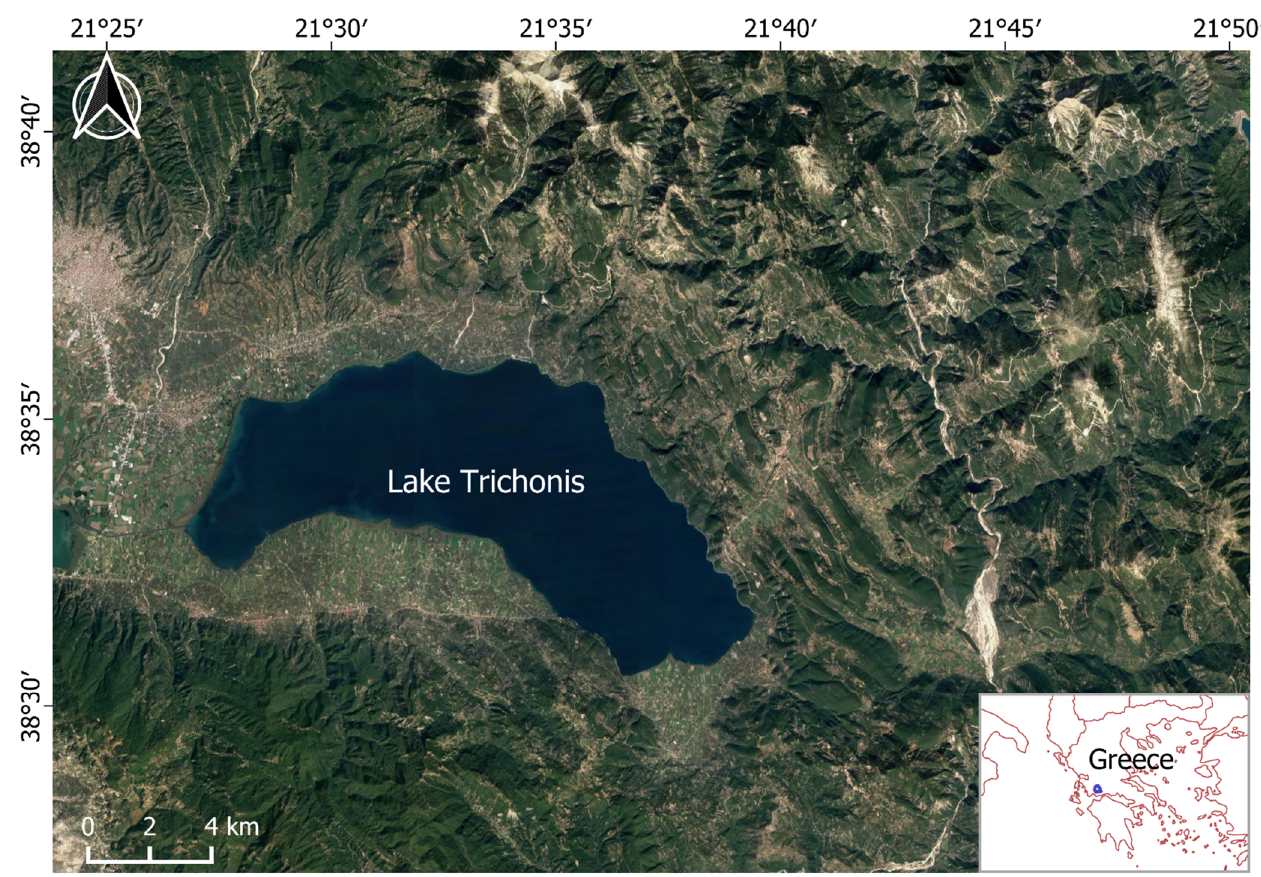
Figure 1. Location of the study area.